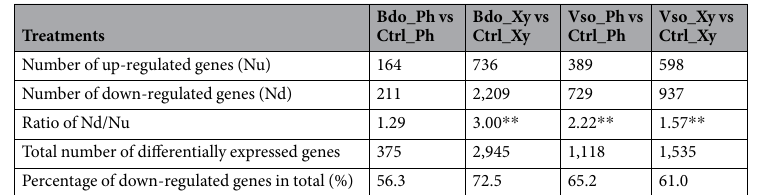
Percentage of down-regulated genes in total (%) 56.3 Table 2. Number of canker pathogens induced differentially expressed genes (DEGs) in the phloem and xylem of poplar stems. Notation: The DEGs were selected using log2(FC) ≥ or ≤− 1 and FDR ≤ 0.05 including those only expressed in one library, and FDR < 0.05. Asterisks indicate the number of down-regulated genes (Nd) is more than that of up-regulated genes (Nu) (Chi-square test, null hypothesis is Nd = Nu; * P < 0.05; ** P <